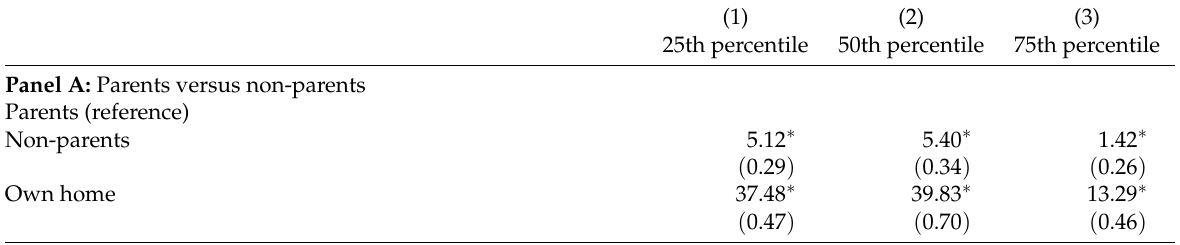
Table 4: Quantile regressions of percentile net worth, by household type, adjusting for homeownership ( N = 41,